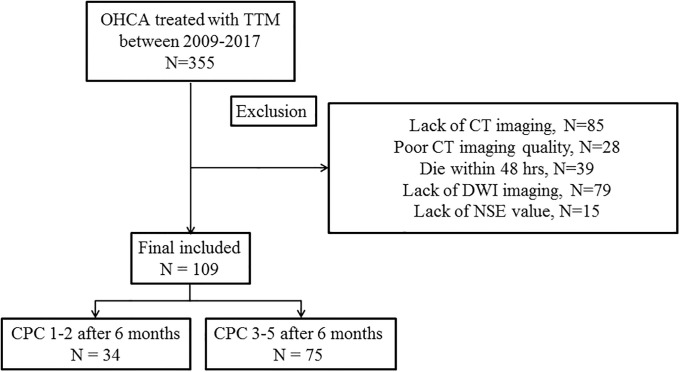
Flowchart for included patients.